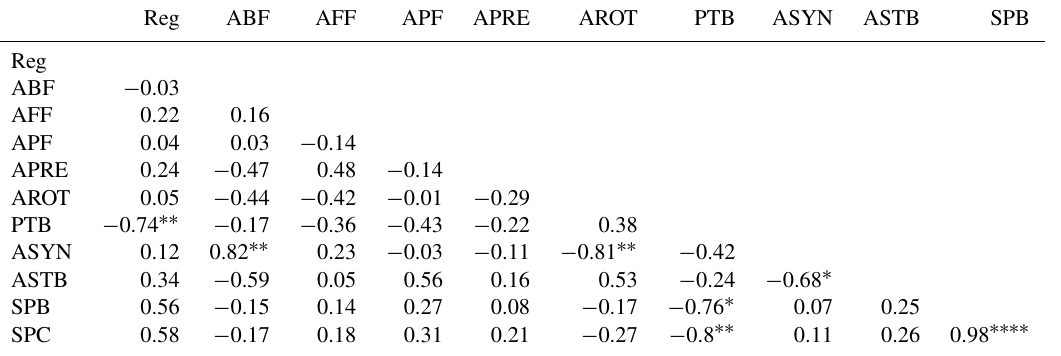
Table 3. Pearson’s correlations among regularity, averaged abundance of all feeding types of nematodes and rotifers, accumulated total biomass of initial A. stolonifera plants, averaged synchrony and stability, and aboveground biomass and plant cover of the new L. perenne and P. lanceolata